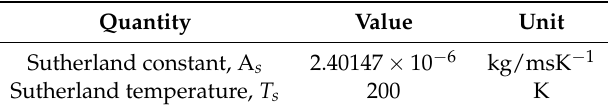
Table 3. Fitted Sutherland viscosity coefficients used.